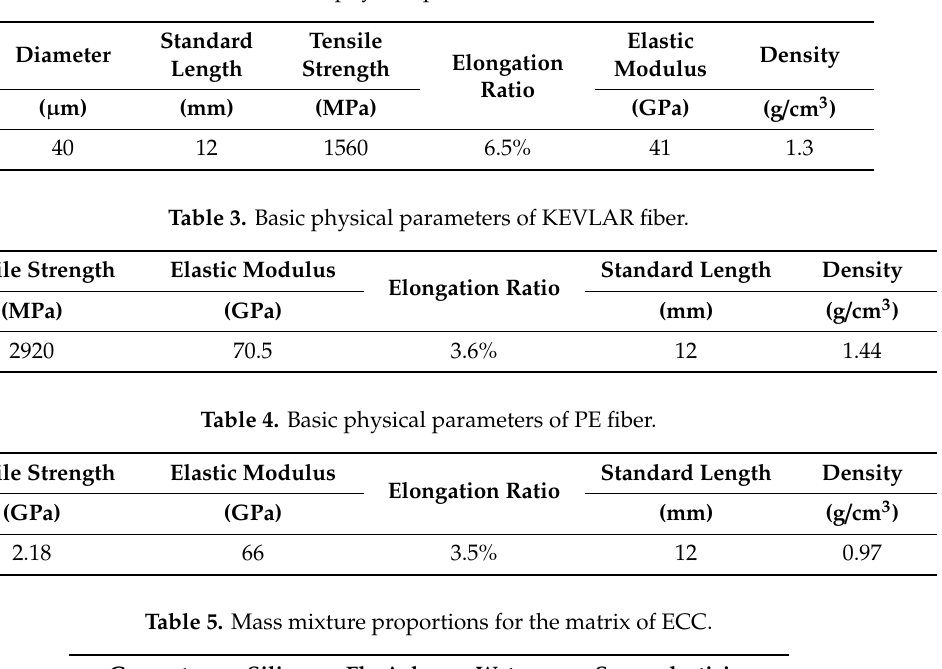
Table 2. Basic physical parameters of PVA fiber.